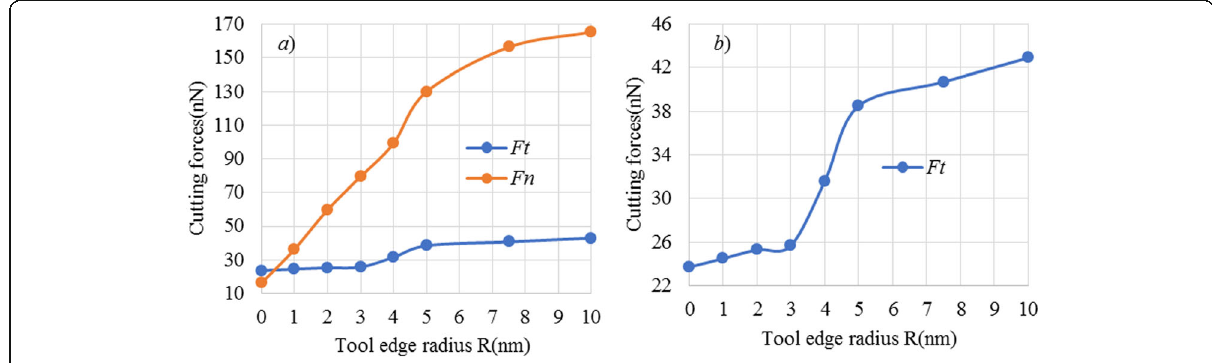
Fig. 12 Plot of cutting forces versus cutting edge radius at cutting depth of 2